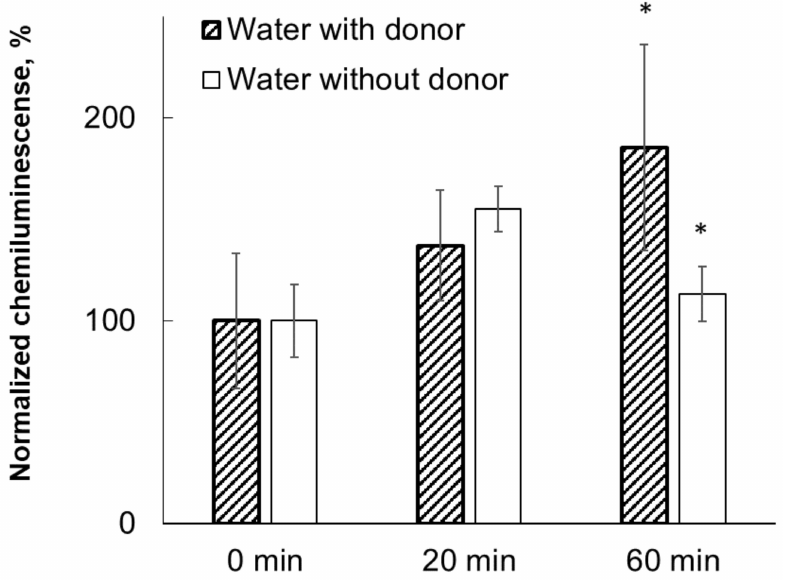
Figure 3. Maximum chemiluminescence intensity of a suspension of neutrophils after the addition of water jointly or separately incubated with samples of HD Abs to IFN γ . The samples contained: suspension of neutrophils—2.5 × 10 5 cells; water incubated for 0, 20, and 60 min in the presence of HD Abs to IFN γ (hatchet bar) or in the absence of HD Abs to IFN γ (white bar), which constituted 80% of the total sample volume; fMLF (2 µ M); luminol (0.35 mM). Measurements were performed at 37 ◦ C and pH 7.4; * p < 0.05 (intragroup